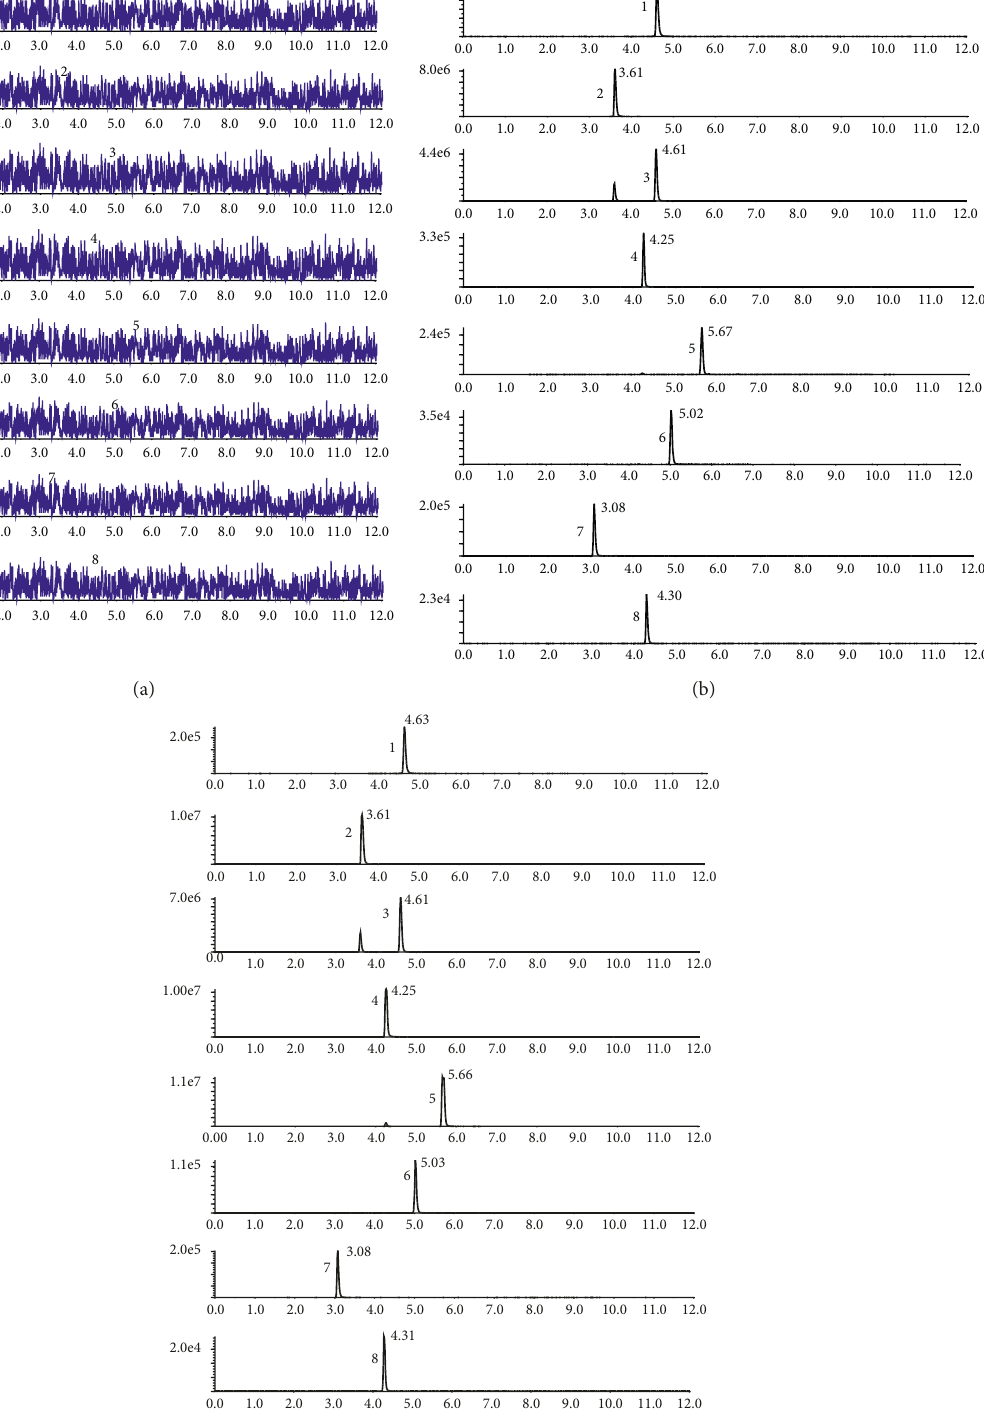
Figure 4: The chromatogram of HPLC-MS/MS. Blank plasma sample (a), blank plasma spiked with six ingredients and IS (b), and plasma samples obtained 30min after oral HQD treatment